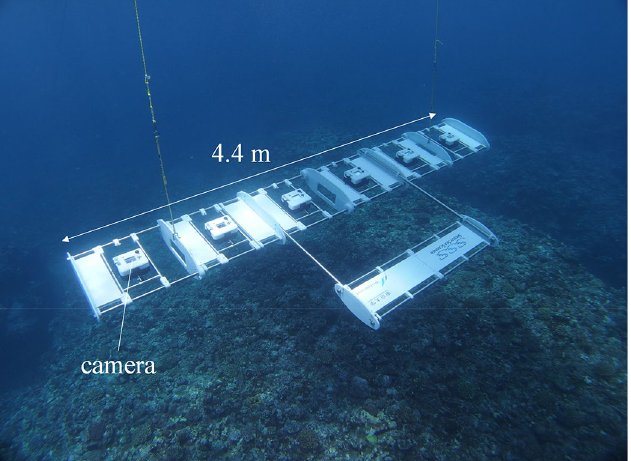
Figure 1. Speedy Sea Scanner (SSS). Six cameras reside on the towed body. The attitude is maintained by the